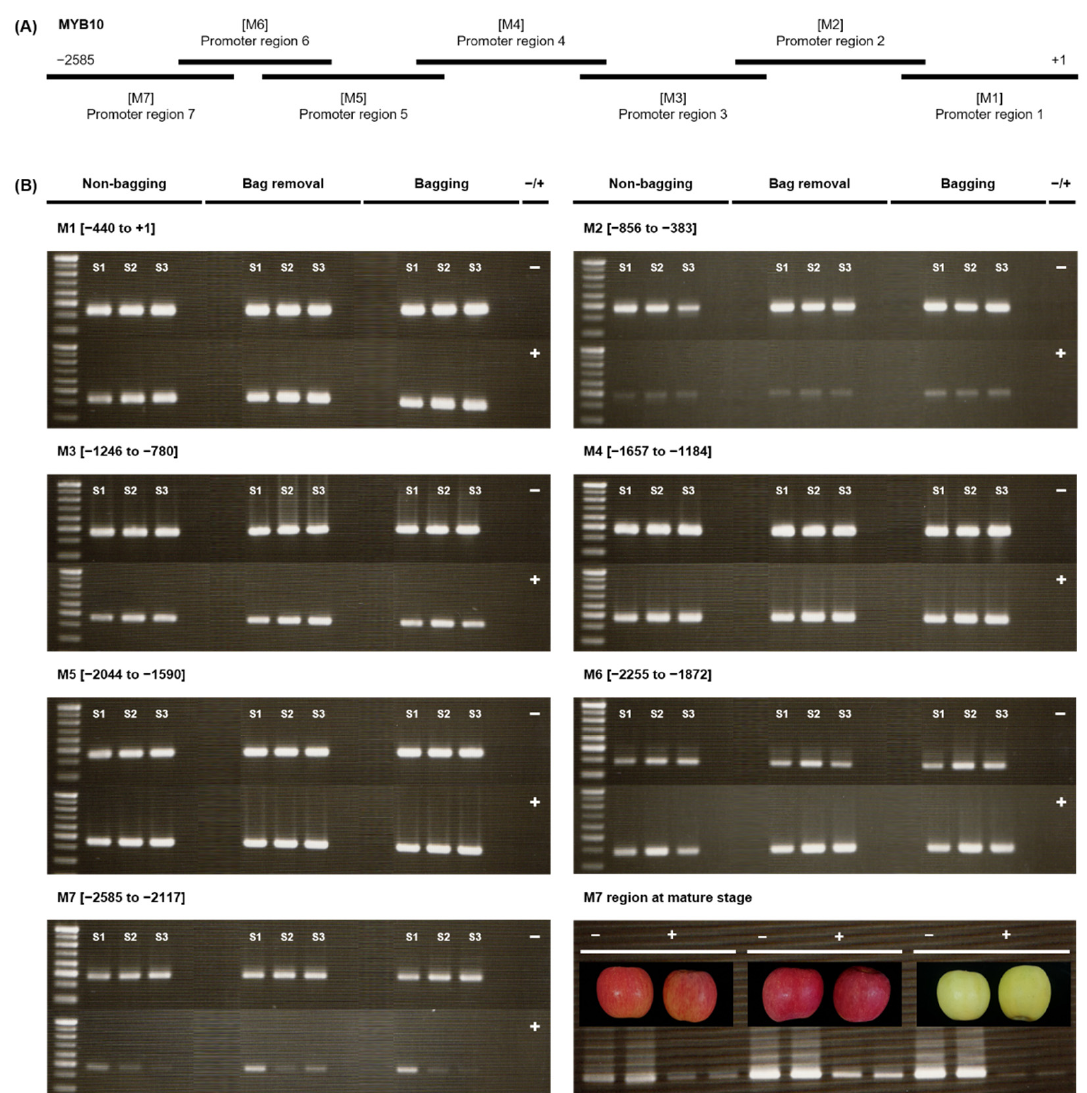
Figure 4. Changes in DNA methylation in the promoter of MdMYB10 during development, effects of bagging treatment, and correlation with ‘Fuji’ apple skin patterning. ( A ) Schematic diagram of 2500 bp upstream of the ATG translational start site of MdMYB10 and its division into seven overlapping fragments: M1-M7. ( B ) McrBC-PCR analysis where 500 ng of genomic DNA was digested with McrBC in the presence of GTP (+) or the absence of GTP ( − ). The absence of GTP served as the negative control. ‘Fuji’ apples were cultivated under different bagging treatments: no bagging (control; labeled as “non-bagging”), bagging followed by bag removal (labeled as “bag removal”), and bagging with no bag removal (labeled as “bagging”). Apples were harvested at three time points: before paper-bagging (S1, DAFB 97) and then 1 and 4 weeks after bag removal (S2, DAFB 169 and S3, DAFB 191). The panel labeled “M7 region at mature stage” shows the apple skin patterning: non-bagging, striped red; bag removal, blushed red; bagging, blushed yellow; +1, ATG translational start site. The last panel shows the technical replication of each treatment in the M7 region at the mature stage (S3). DAFB, days after full bloom.